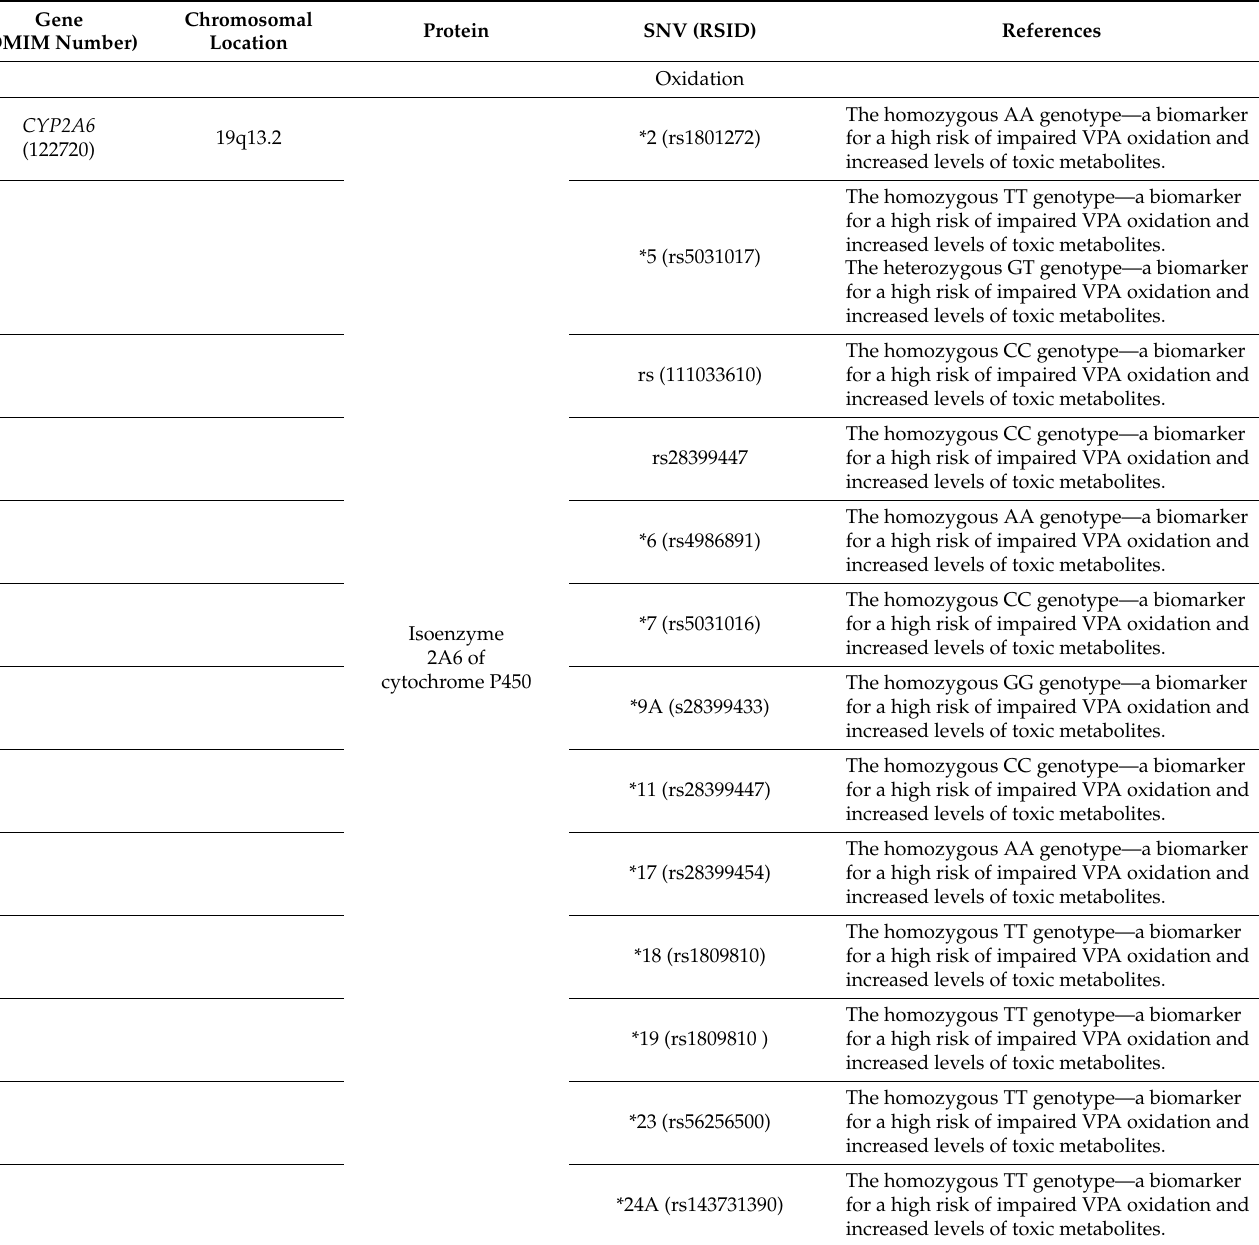
Table A1. Genetic Biomarkers of Valproic Acid Metabolism